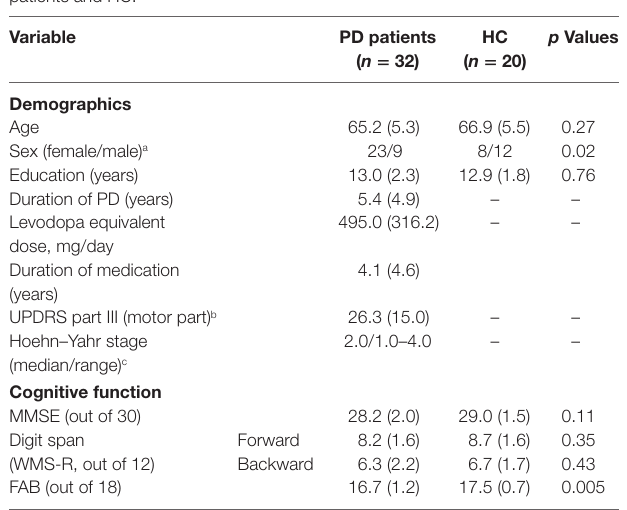
taBle 1 | Demographic and neuropsychological data (mean ± SD) of PD patients and